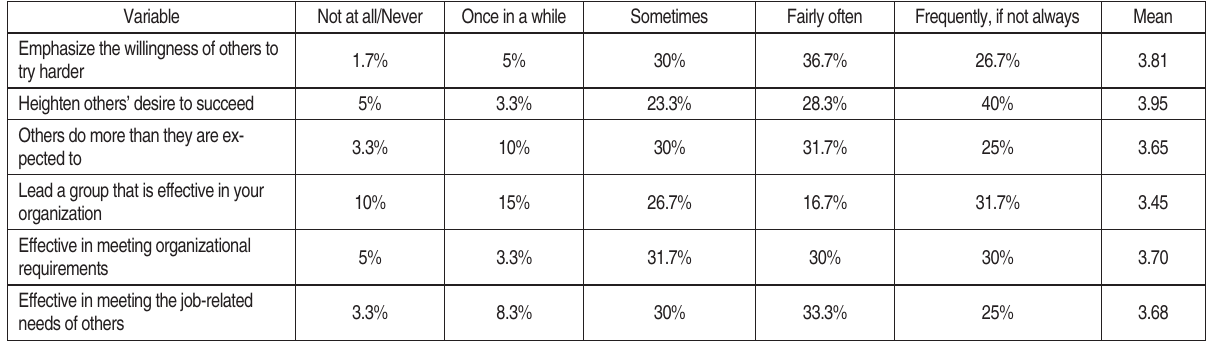
Table 5. Outcomes of leadership styles of the manager/supervisor